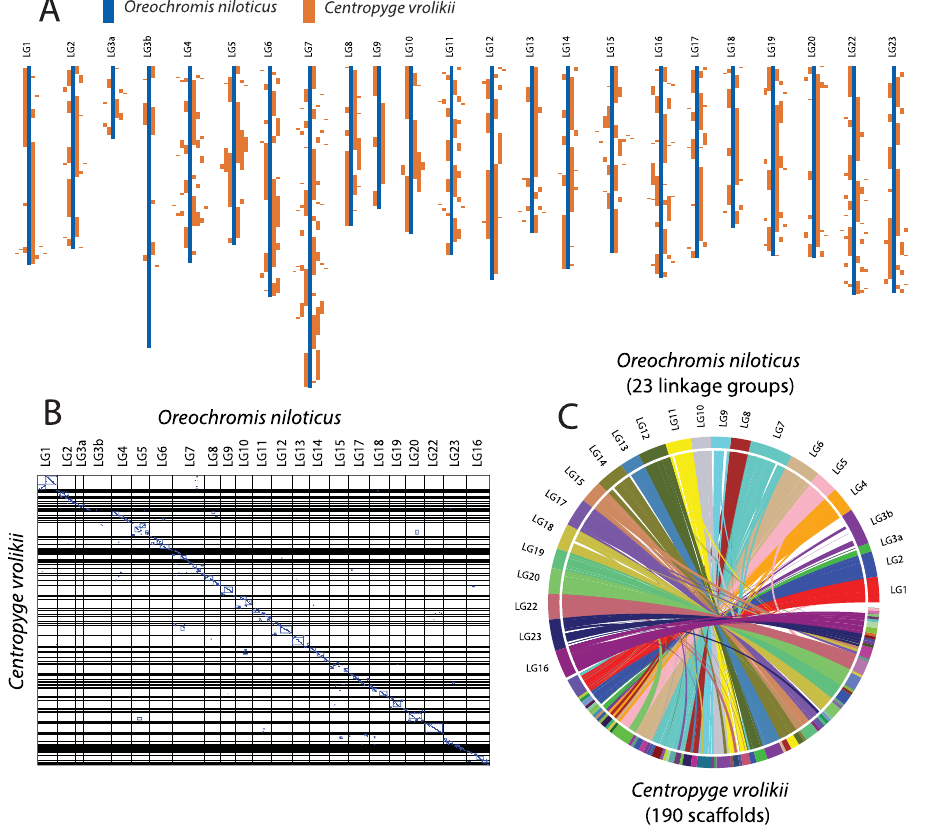
Figure 5. SyMAP synteny analyses between C. vrolikii and O. niloticus . ( A ) Syntenic mapping of C. vrolikii contigs to the O. niloticus chromosomes (a.k.a. linkage groups). ( B ) Whole genome dot plot. Dots represent anchors (“sequence matches”) and blue boxes indicate synteny blocks determined by the SyMap synteny-finding algorithm 27 . ( C ) Circular view of the synteny between C. vrolikii contigs and the O. niloticus